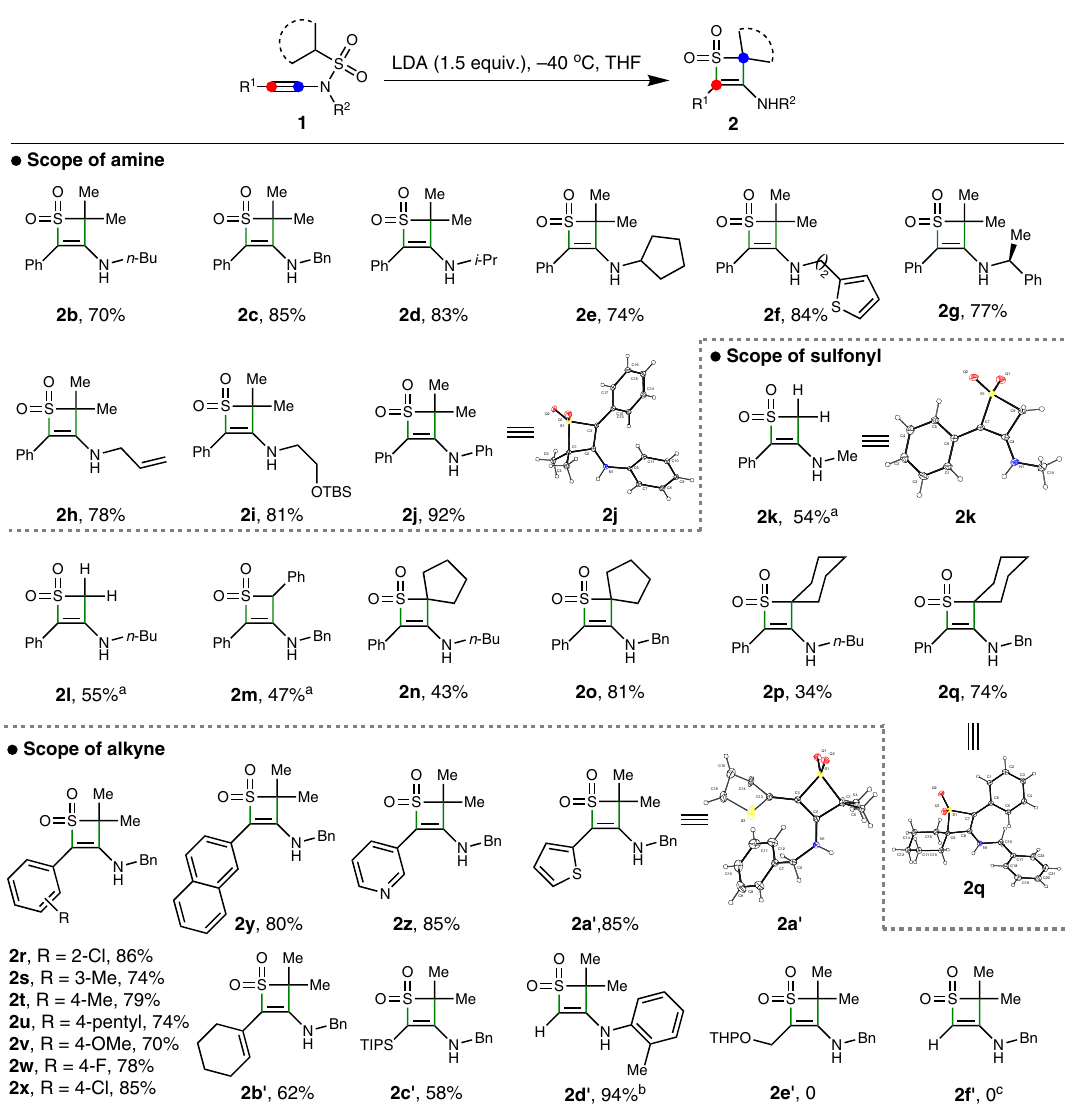
Fig. 4 Scope of thiete sulfones. Standard condition: 1 (0.2 mmol), LDA (0.3 mmol), THF (2 mL), − 40 °C, 1 h, then treated with MeOH (0.1 mL). Yields refer to isolated products. a 0.6 mmol LDA was used. b Product of desilylation. c From the terminal